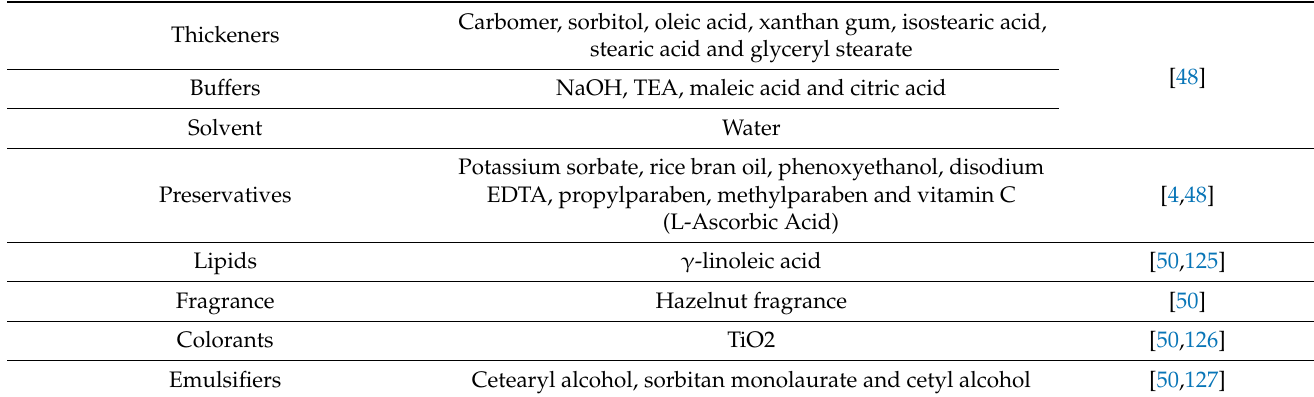
Table 2. Common Inactive Ingredients.